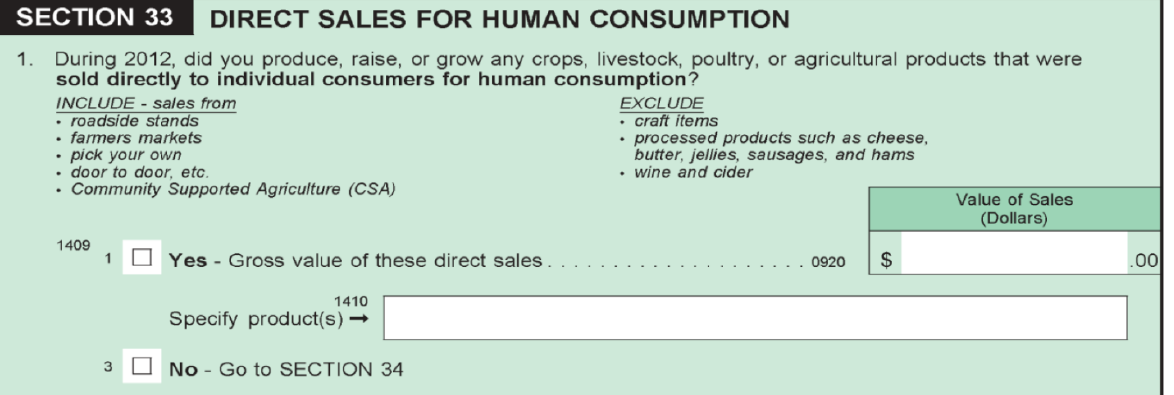
Figure 1. 2012 Census of Agriculture